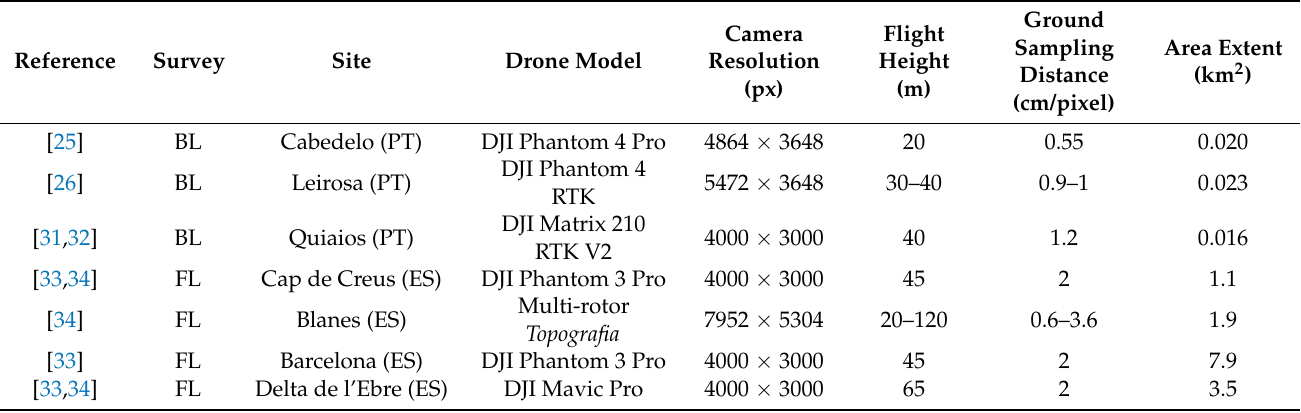
Figure 1. Study sites and field work experiences considered for beached (BL) and floating (FL) litter. ( a ) map of the Iberian Peninsula, with study sites locations on the Portuguese coast for BL (left), and on the Spanish coast for FL surveys (right). The number associated to the study sites indicate the related references (see reference list). ( b ) Pictures of BL surveys: (I) overview of Quiaios dunes [31,32]; (II) overview of Cabedelo beach [25], inset shows the drone; (III) overview of Leirosa beach [26]; (IV) detail of BL on Leirosa beach [26]. ( c ) Pictures of FL surveys: (I) overview of the catamaran in Delta de l’Ebre [33,34]; (II) detail of the drone flight in Barcelona [33]; (III) detail of the drone flight deployment at Delta de l’Ebre [33,34]; (IV) overview of the vessel in Cap de Creus [33,34]. Table 1. Operational drone flight parameters used in the experiences considered in this work for beached (BL) and floating (FL)